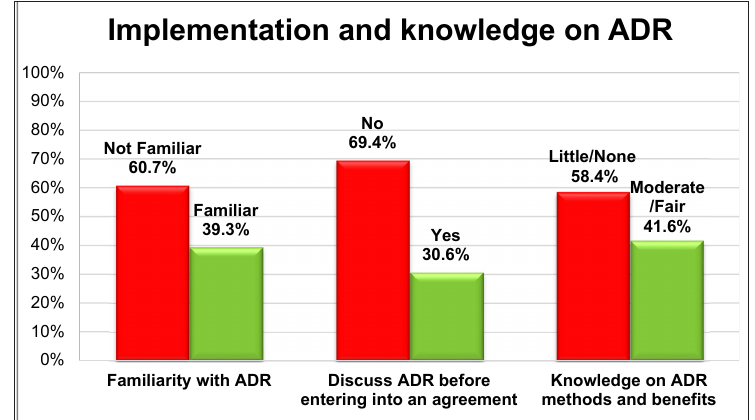
Figure 6: Graphic summary of the implementation and knowledge regarding ADR in the SAIA CAA